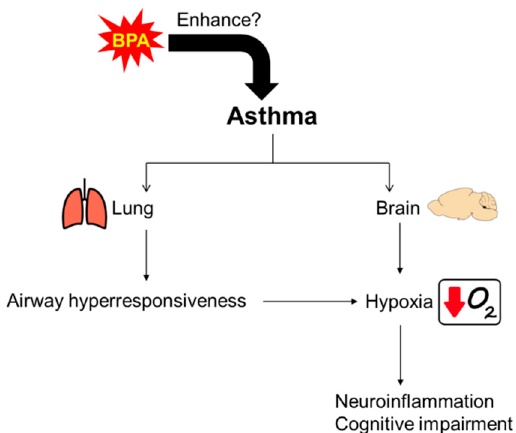
Figure 1. Illustration of possible brain–lung network in asthma. Asthma may induce brain hypoxia and cause inflammatory responses via inflammatory and oxidative stress markers and also induce cognitive impairment via hippocampal memory function related genes. Bisphenol A (BPA) exposure may enhance these effects.